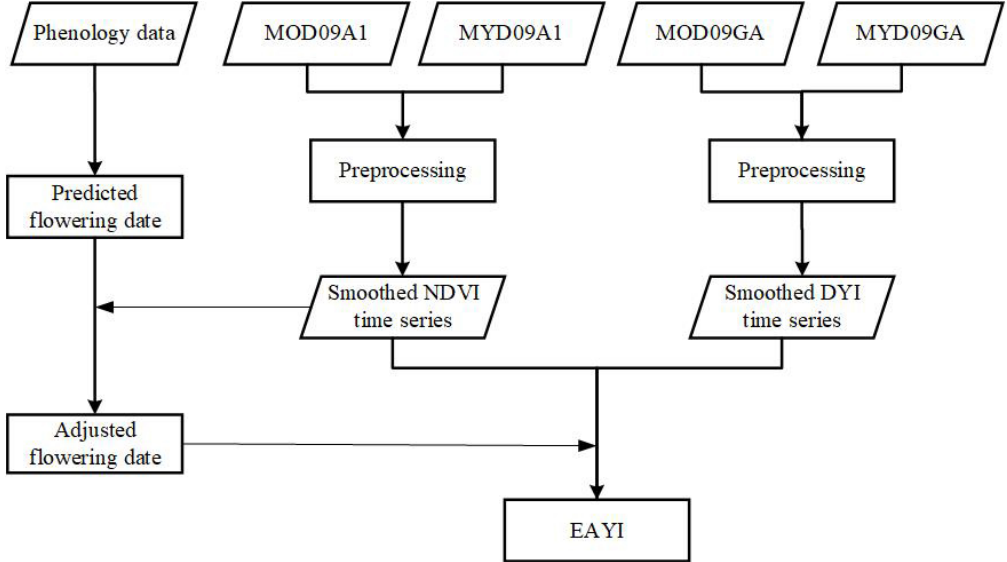
Figure 5. Workflow of generating the EAYI.